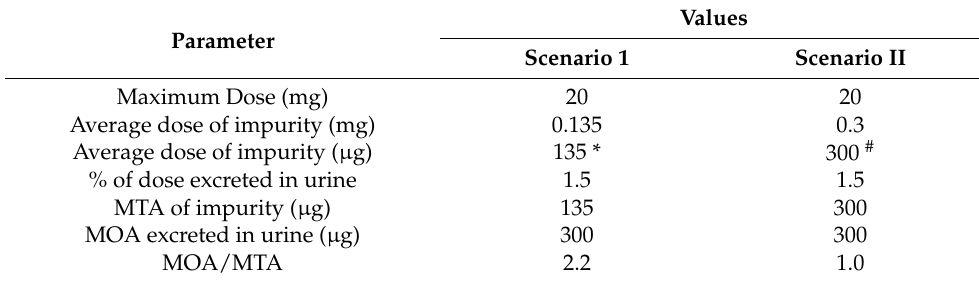
Table 3. Observed metabolite and theoretical impurity amounts of impurity B formed from vildagliptin and excreted in faeces following oral administration in